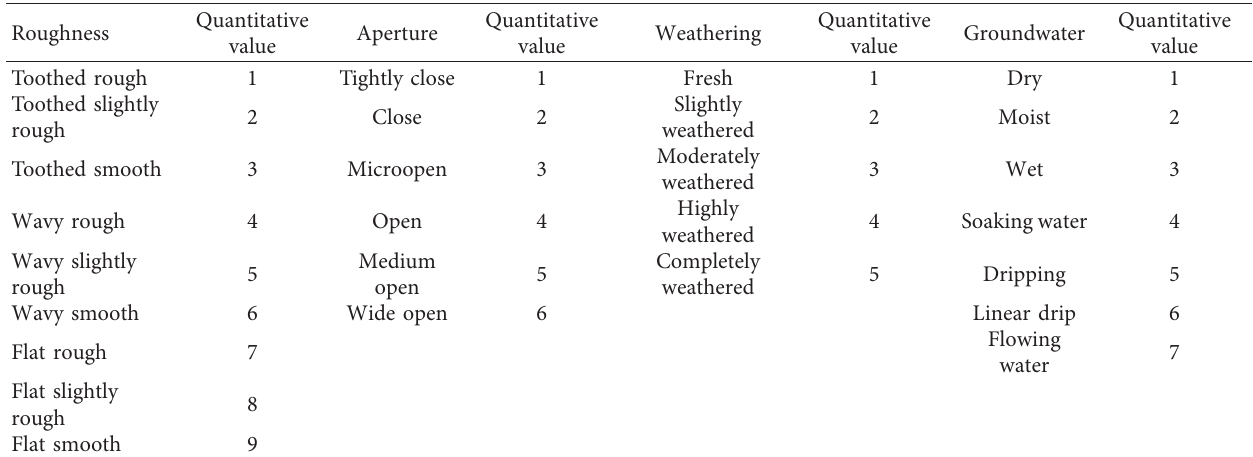
Table 2: Quantitative table for the evaluation index of rock mass